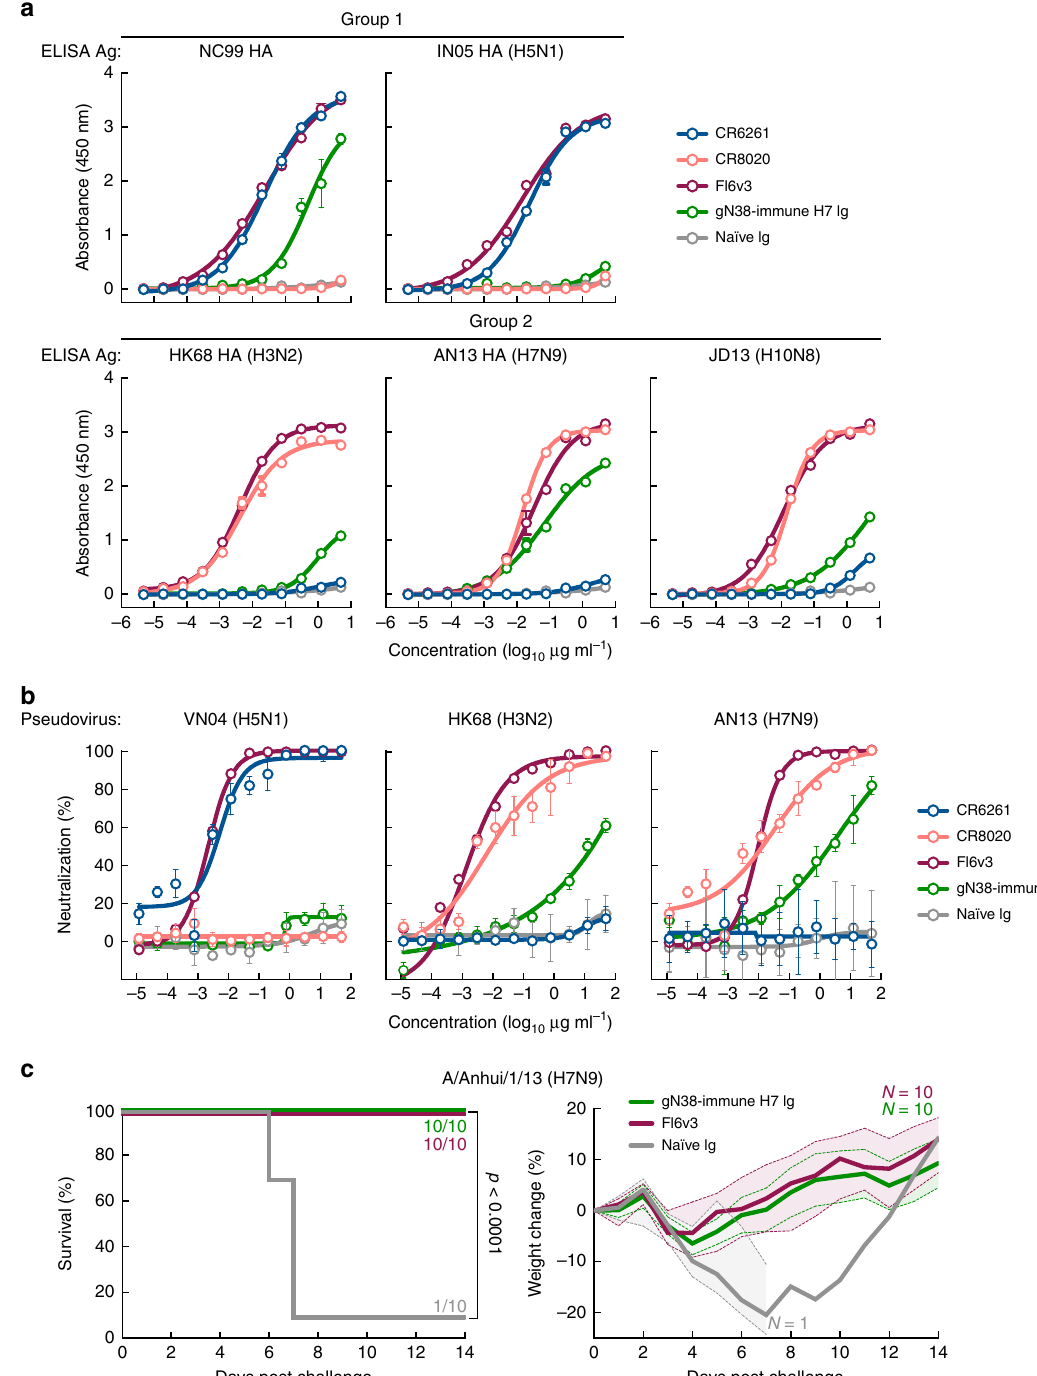
Fig. 5 Cross-group neutralization and protective capacity of immunoglobulins isolated from mice immunized with H1 stem nanoparticle gN38 variant. Immune Ig were obtained from H1ssF gN38-immunized mice by af fi nity-purifying with H7 (AN13) HA. a ELISA binding pro fi le of puri fi ed Ig to HA from NC99, H5N1 IN05, H3N2 HK68, H7N9 AN13, and H10N8 JD13. b Neutralization pro fi le of puri fi ed Ig to H5N1 VN04 (left), H3N2 HK68 (center), and H7N9 AN13 (right) pseudoviruses. Data are shown as mean ± s.d. c Passive immunization of puri fi ed Ig in naïve BALB/c mice ( N = 10). Mice were given 0.2 mg of puri fi ed Ig from either naïve or H1ssF gN38-immunized mice, or bNAb FI6v3 (0.1 mg) intraperitoneally 24 h prior to H7N9 virus challenge (10 × LD 50 ). Mice were monitored twice daily for their weight and activity for 14 days post infection. Statistical test to compare multiple Kaplan – Meier curves was carried out by using Mantel-Cox log-rank test with Bonferroni correction. Displayed results are from one experiment. Source data are provided as Source Data fi